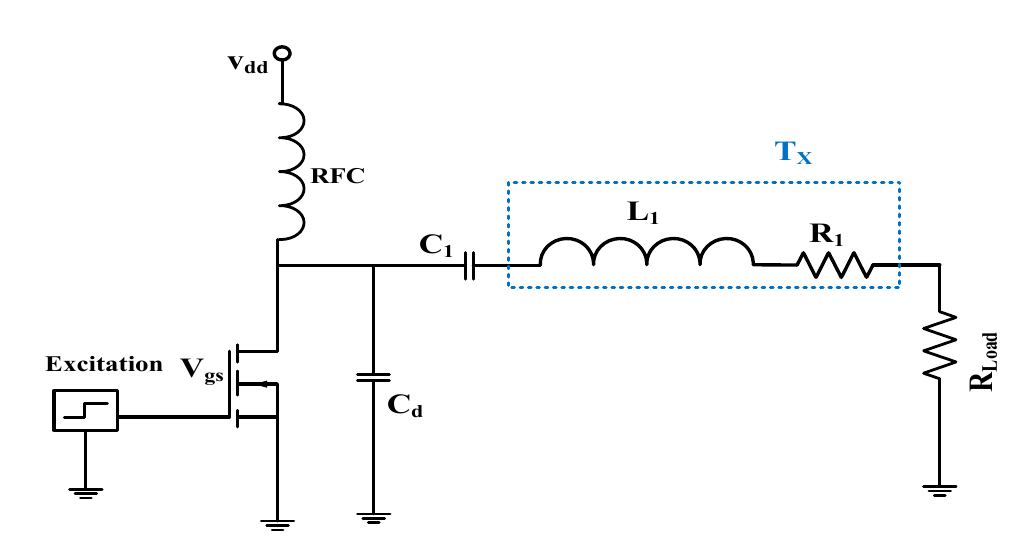
Figure 5. Class-E power amplifier.